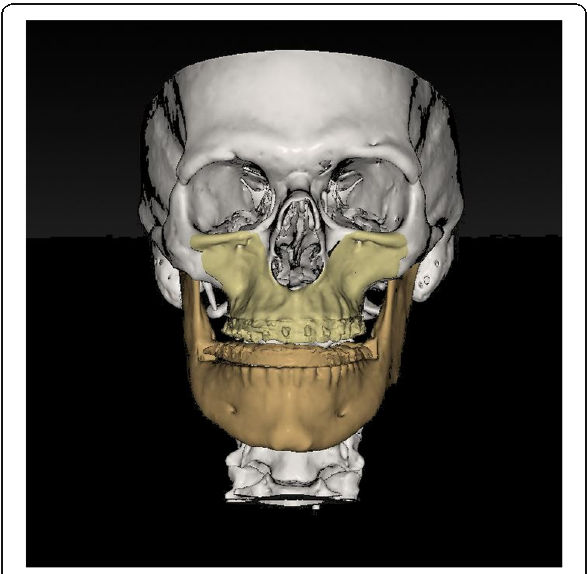
Fig. 2 IQLFIIO segment and the Mandible in the target occlusion in IPS Case Designer